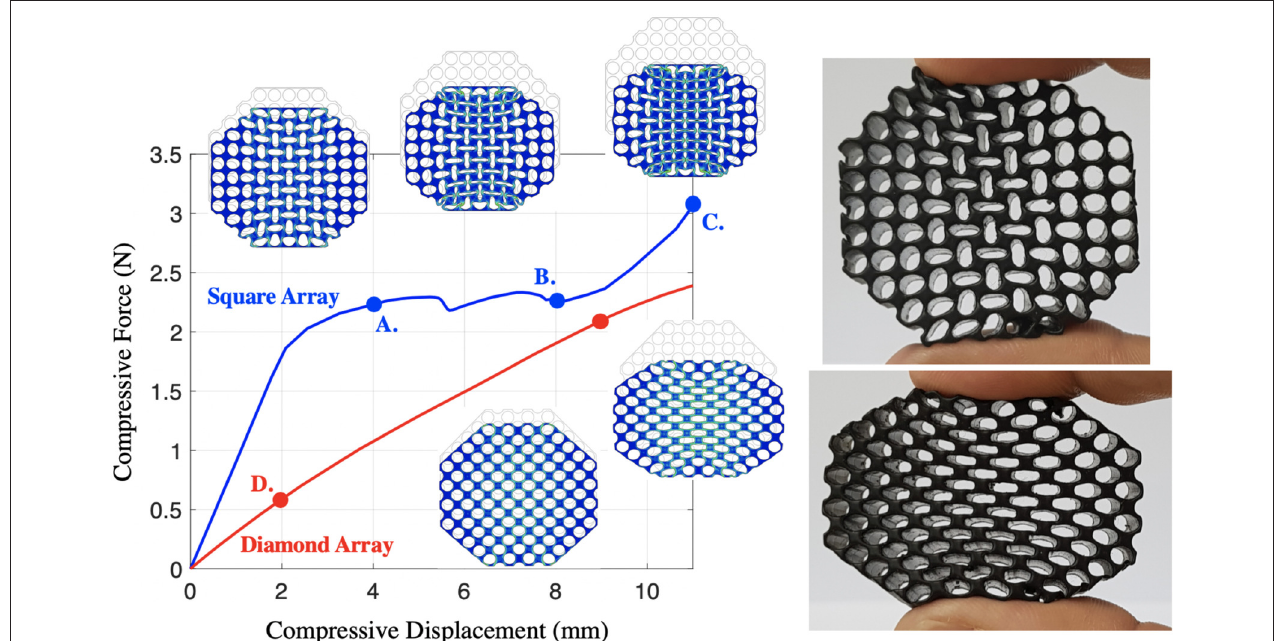
FIGURE 21 | ( Left ) Shows 2D simulations of hexagonal lattices under different configurations (square and diamond) using ABAQUS. The geometry is discretized with 40,000 triangular elements, and model as linear elastic material under large deformation, strain and contact. ( Right ) Shows manufactured specimens in each of the